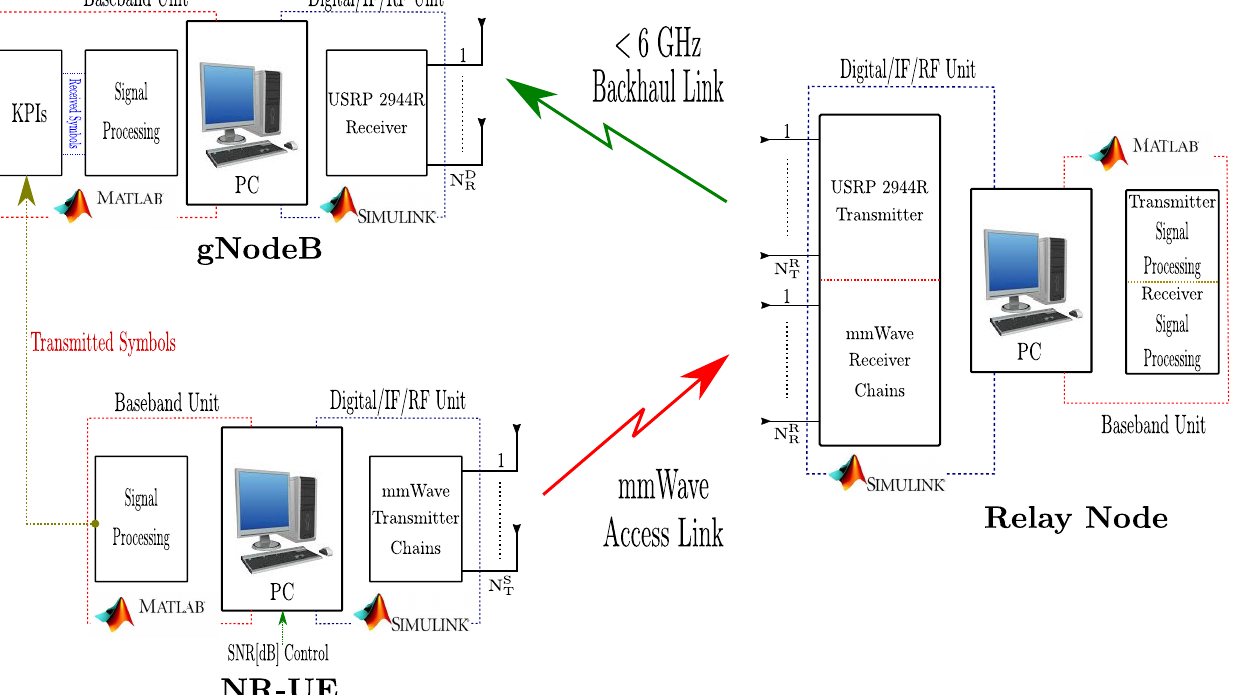
Figure 7. Architecture of the link-level co-operative simulator for uplink mmWave MIMO NR relay node